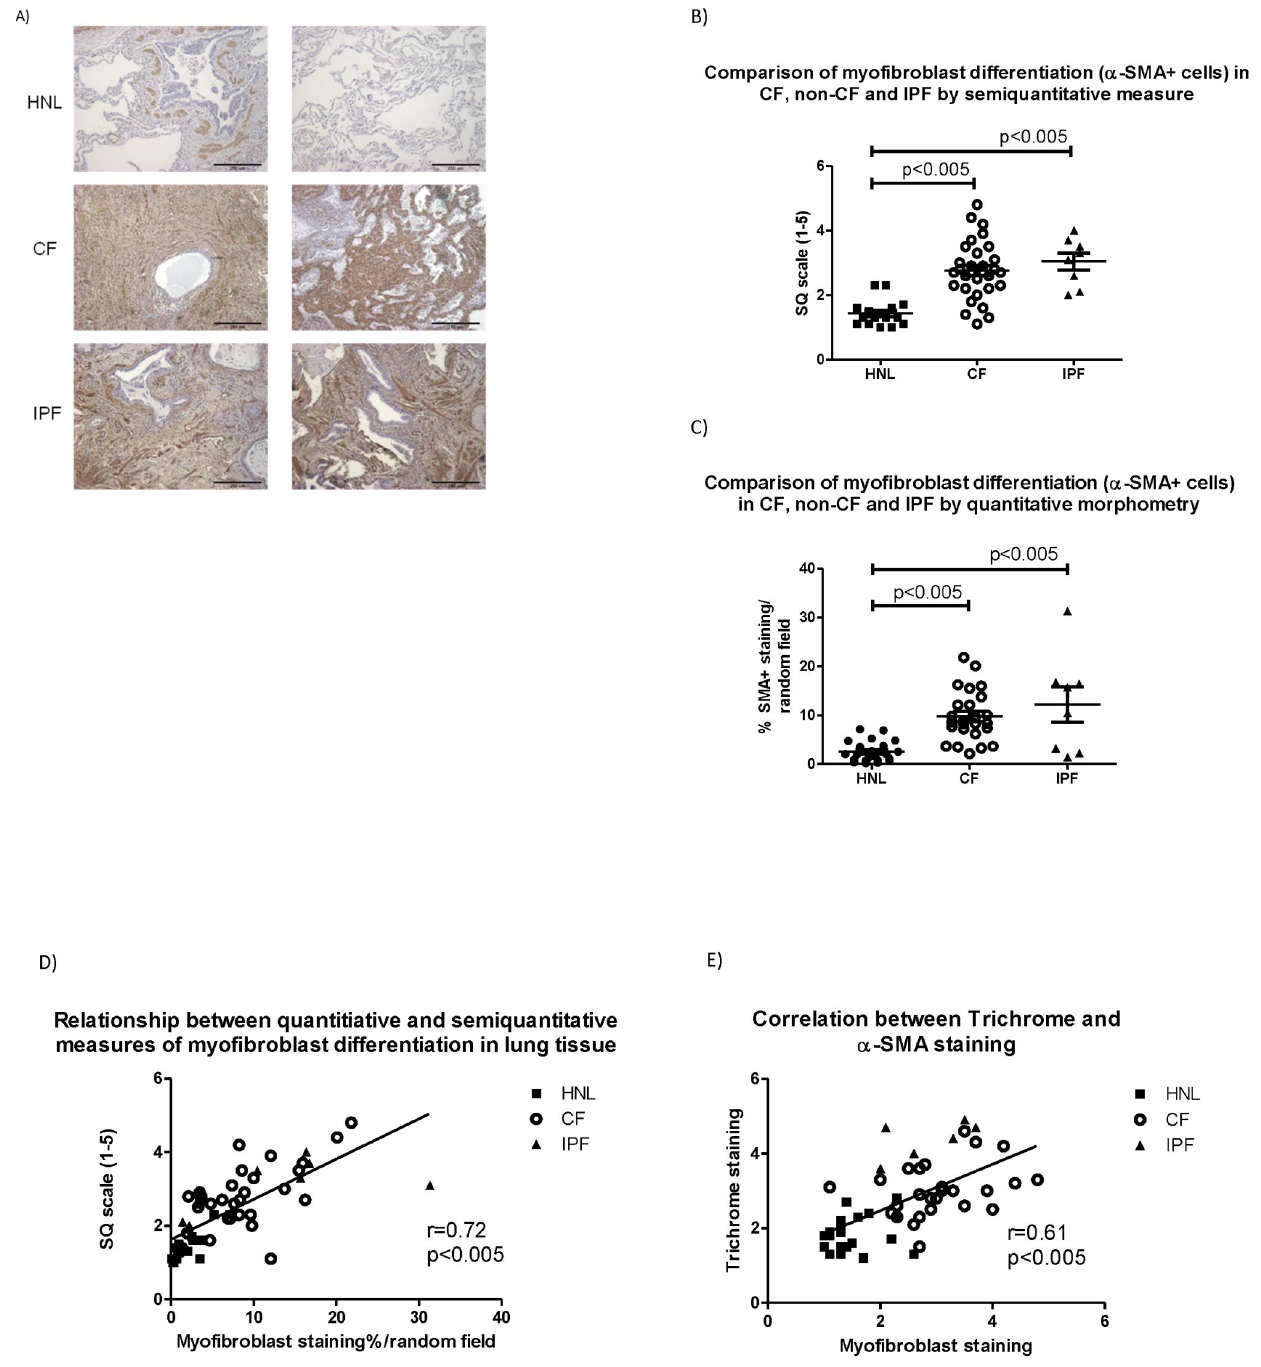
Figure 3. Myofibroblast differentiation in human normal (HNL), cystic fibrosis (CF) and idiopathic pulmonary fibrosis (IPF) lung tissue. A) Immunohistochemical staining for a -smooth muscle actin ( a -SMA), the contractile element in myofibrobroblasts. Myofibroblast accumulation is significantly accentuated in cystic fibrosis (CF) and idiopathic pulmonary fibrosis (IPF) compared to non-diseased controls. Images at 100 6 (bar=250 m m). B) Comparison of myofibroblast differentiation in HNL, CF and IPF lung tissue analyzed semi-quantitatively. C) Comparison of myofibroblast differentiation in HNL, CF and IPF lung tissue analyzed by quantitative morphology. D) Correlation between semiquantitative and quantitative measures of myofibroblast differentiation in HNL, CF and IPF lung tissue specimens. E) Myofibroblast differentiation versus tissue fibrosis in HNL, CF and IPF lung tissue specimens.